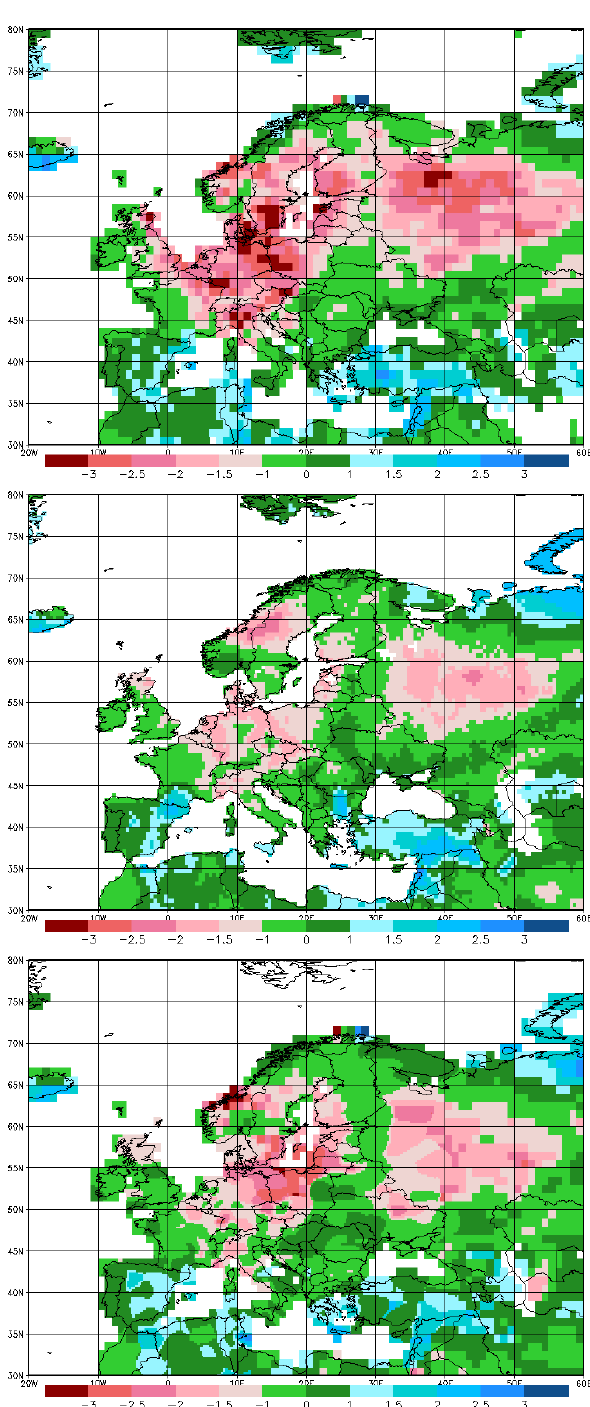
Figure 14. Comparison of the GPCC-DI (top), SPEI (middle) and SPI-EDO (bottom) with 1-month aggregating interval for Febru- ary 2003. The color scale is the same as in Fig.